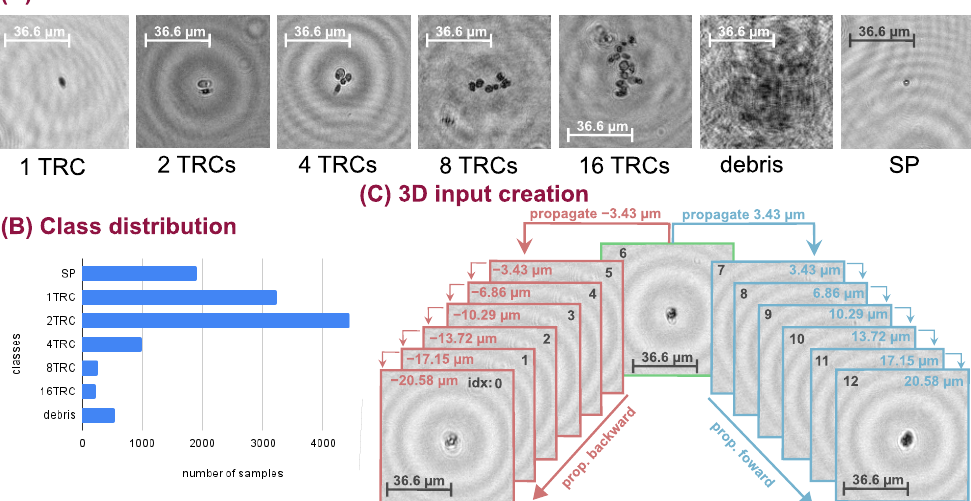
Figure 1. ( A ) Samples from the classes. ( B ) Distribution of the number of samples in classes. ( C ) The volumetric input creation for the 3D neural network. Note that only the hologram’s ampli- tude image is shown and the phase image is omitted in this illustration for the sake of simplicity. The backward and forward propagation terms denote the direction of the